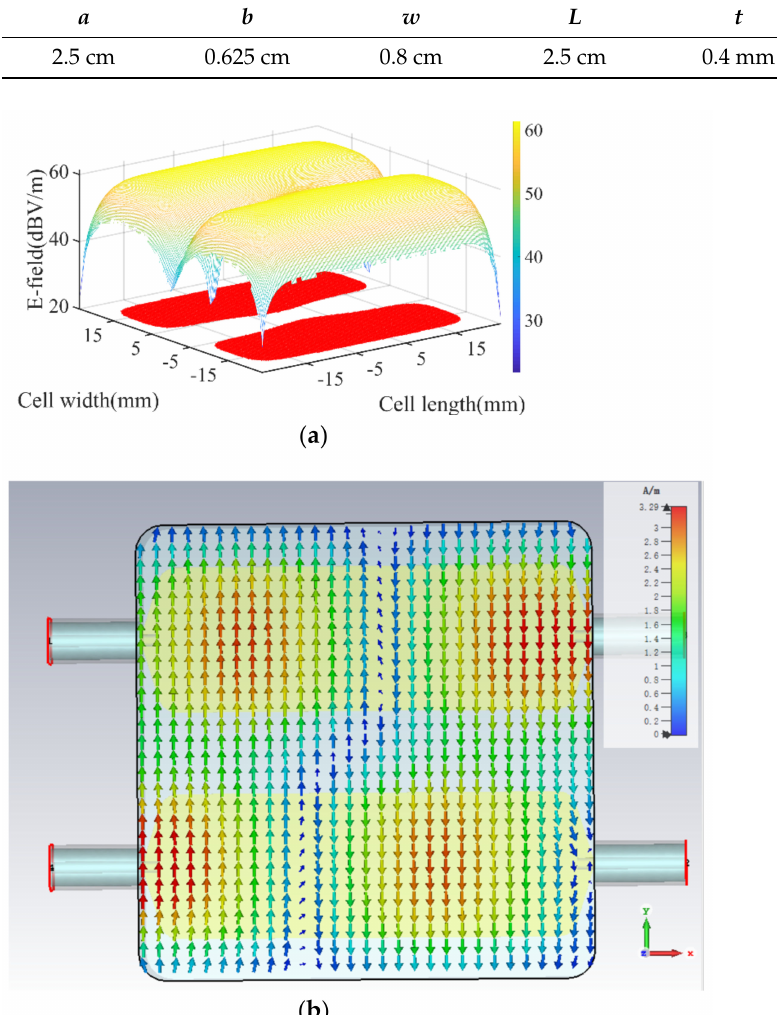
Figure 16. Field distribution at the top area of the scaled-down IC-Stripline cell based on image theory. ( a ) The electric field distribution (the red shaded area is the horizontal projection of the 3 dB uniform field region). ( b ) The magnetic field